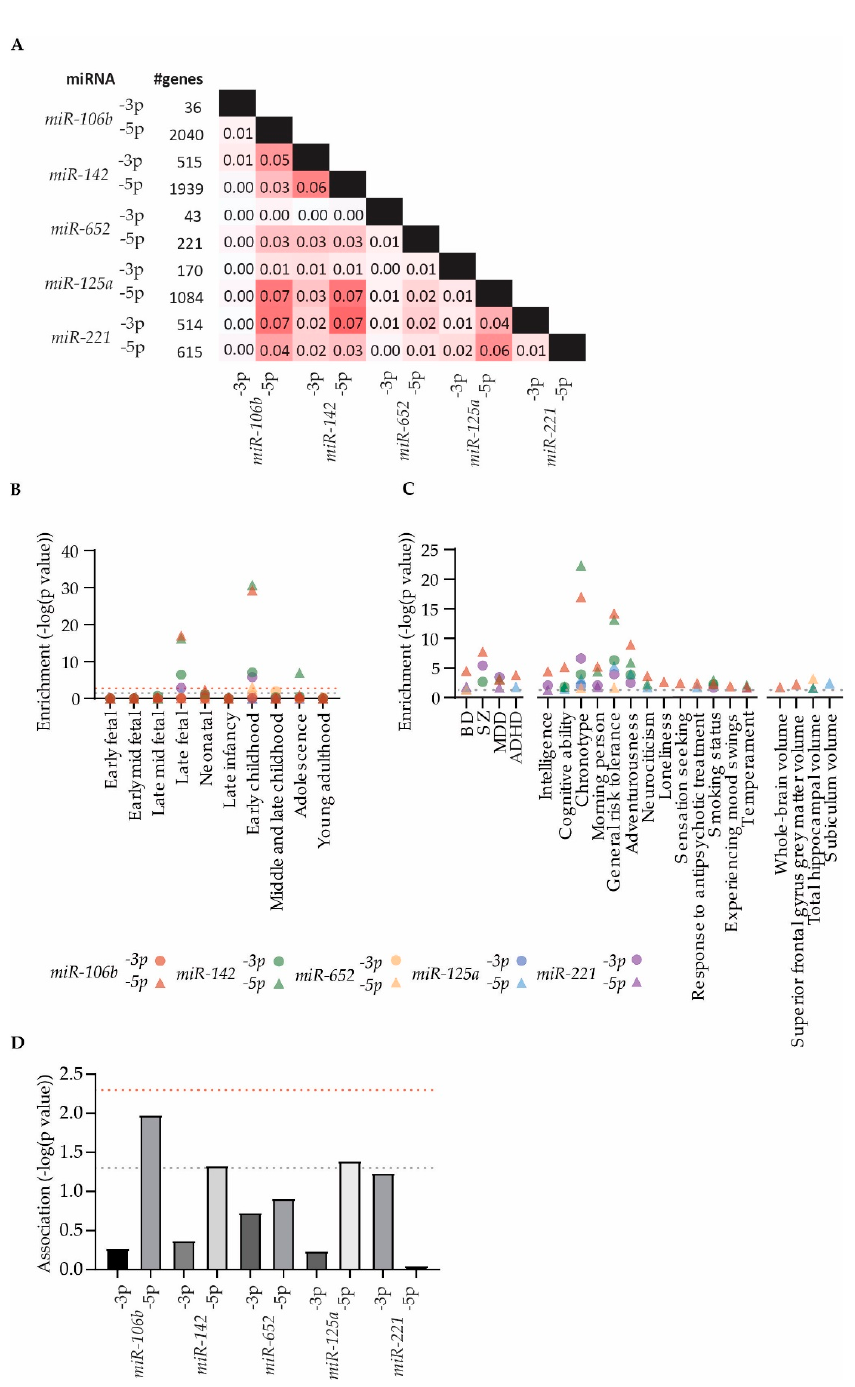
Figure 4. Characterization of predicted miRNA target genes. ( A ) Jaccard similarity index of predicted target gene sets of the five putative BD miRNA biomarkers. ( B ) Enrichment of genes with differential expression in brain tissue at 10 developmental stages. Grey dotted line marks nominal significant cutoff at p = 0.05, while red dotted line marks significance cutoff adjusted for multiple testing. ( C ) Enrichment of GWAS catalog genes that surpass nominal significant cutoff at p = 0.05 (grey dotted line) within the categories: (1) major psychiatric disorders; (2) BD-associated traits; and (3) brain-morphometric traits. ( D ) MAGMA gene set associations for each of the predicted miRNA target gene sets, calculated based on summary statistics from Mullins et al. [11]. Grey dotted line marks nominal significant cutoff at p = 0.05, while red dotted line marks significance cutoff adjusted for multiple